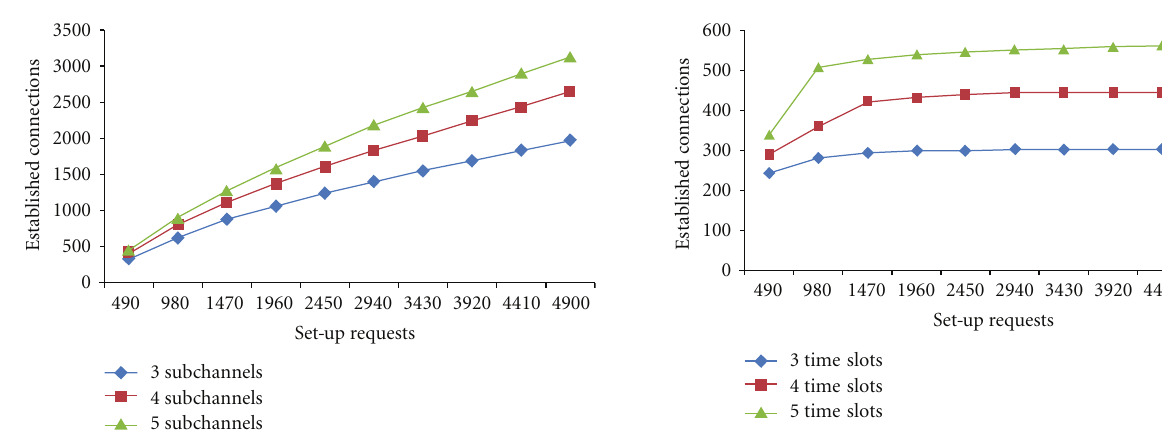
Figure 24: Established connections in 7 × 7 SDM-NoC.